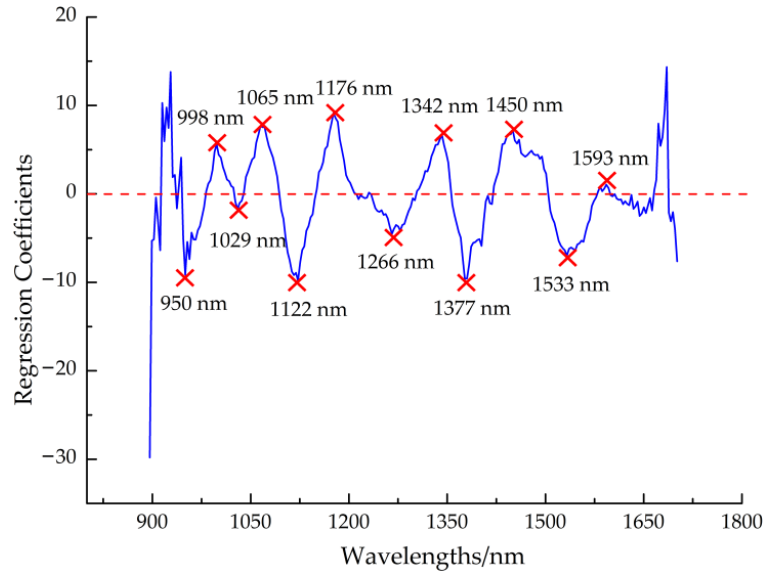
Figure 4. Characteristic wavelength selection results of RC.